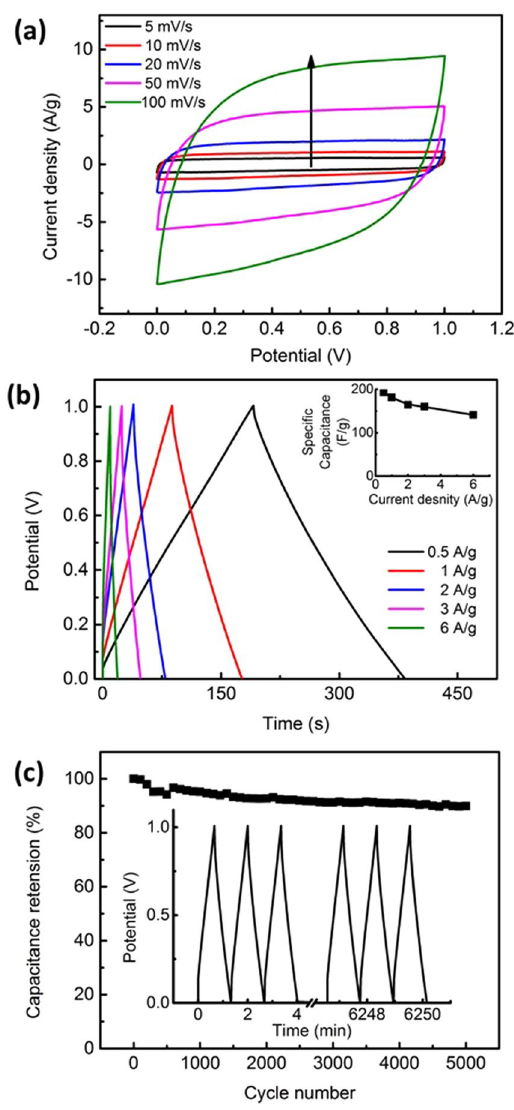
Figure 4. ( a ) Cyclic voltammetry (CV) and ( b ) galvanostatic charging–discharging (GCD) profiles of symmetric SC-PA KOH (inset: specific capacitance verses current density). The arrow in ( a ) indicates the direction of increasing scanning rate. ( c ) Cycle test of the fabricated supercapacitor (SC-PA). The inset presents first and last three galvanostatic charging–discharging (GCD)